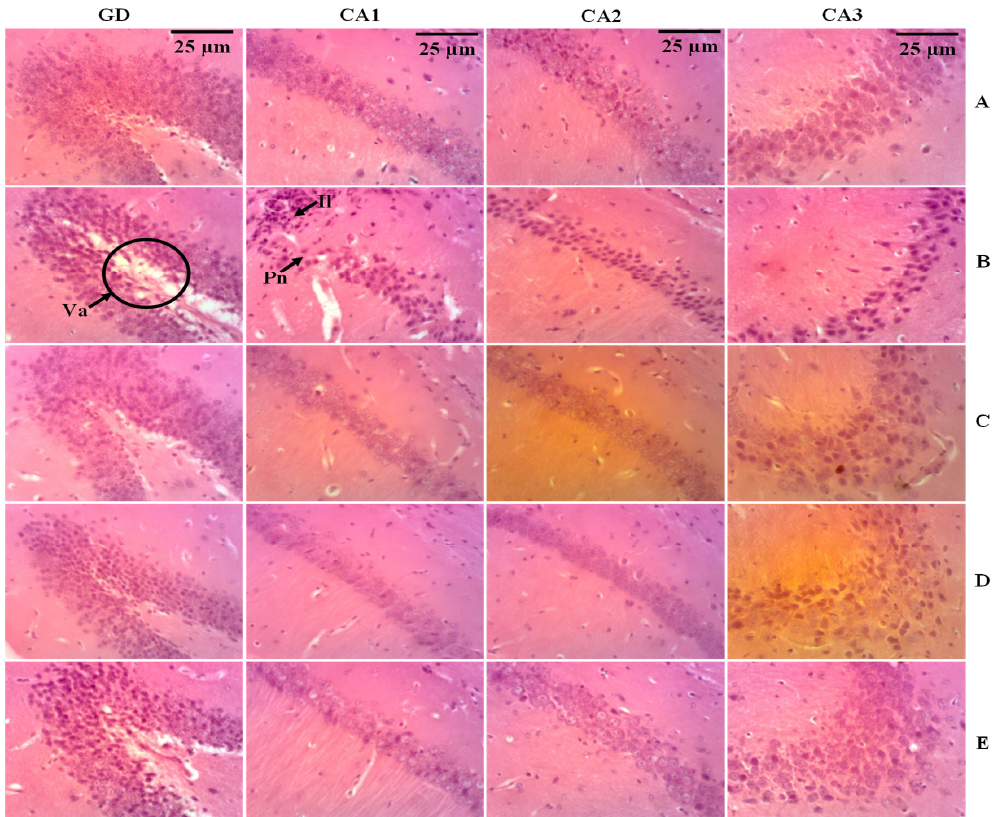
Figure 5. Microphotographs of the gyrus dente (X100) and Ammon horns 1, 2 and 3 (X200) of the hippocampus of male mice; Hematoxylin-Eosin staining. A = Normal control; B = Negative control; C = Positive control; D, E = Batches receiving DCM/MeOH extract of C. adansonii at doses of 150 and 300 mg/kg, respectively; GD = Gyrus dente; CA1, 2, 3 = Ammon horns 1, 2, and 3; Pn = Neuronal loss; Va = Neuronal vacuolation; Il = Leukocyte